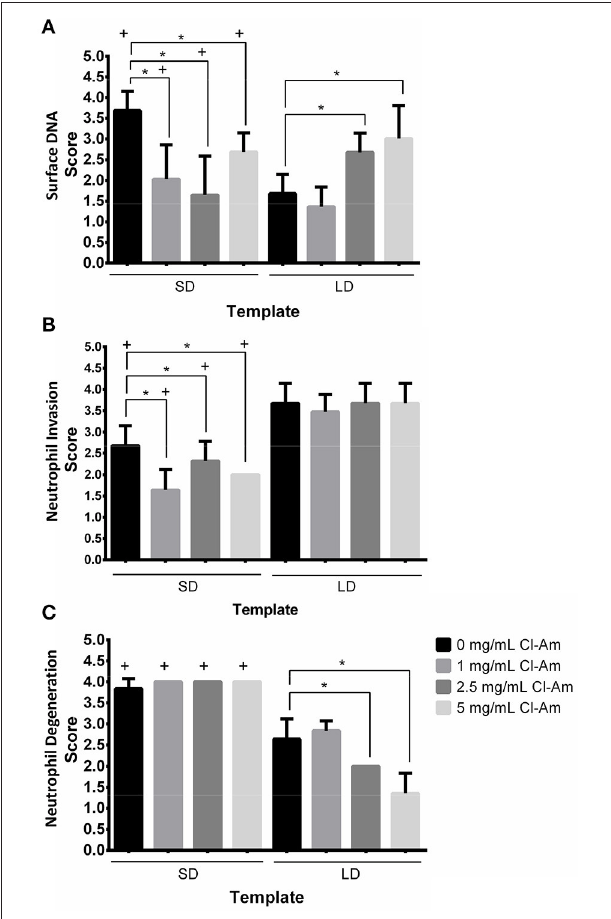
FIGURE 10 | Cl-Am eluting templates modulate cell behavior in vivo . Histological scores obtained from a blinded, veterinary pathologist for (A) presence of surface DNA, (B) invasion into the template, and (C) degree of neutrophil degeneration after 1 day implantation. *Significant difference ( p < 0.05). + Significant difference between SD and LD templates ( p < 0.05) (mean ± std. dev., n = 3).